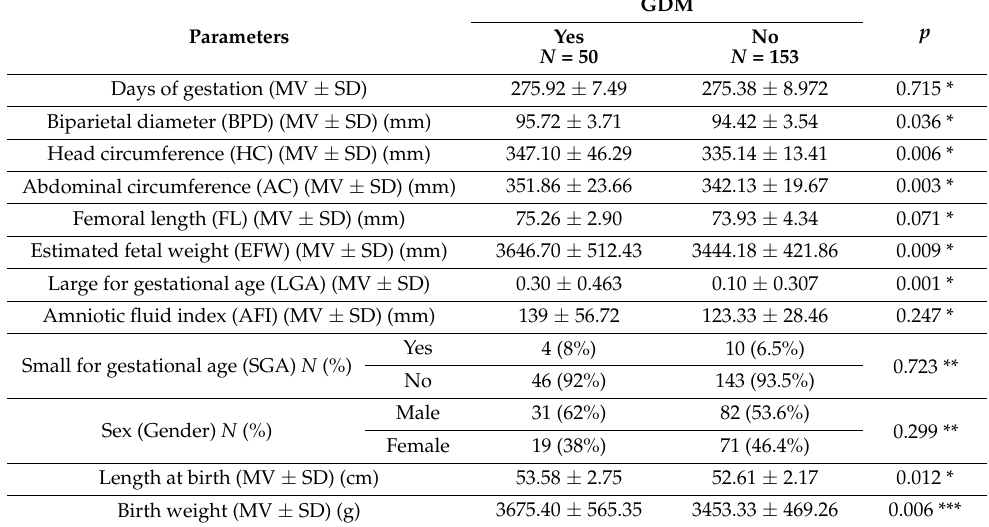
Table 2. Fetal and neonatal parameters characteristics due to the presence of gestational diabetes mellitus ( N =